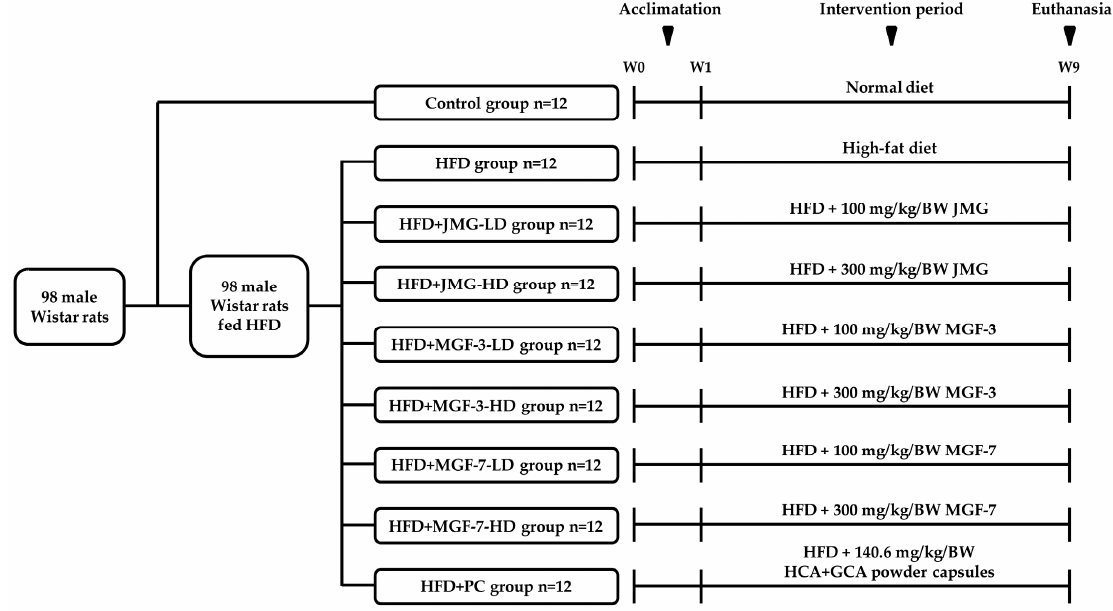
Figure 1. Flow diagram of the study on the anti-obesity effects of the Mei-Gin formula in rats with HFD-induced obesity.